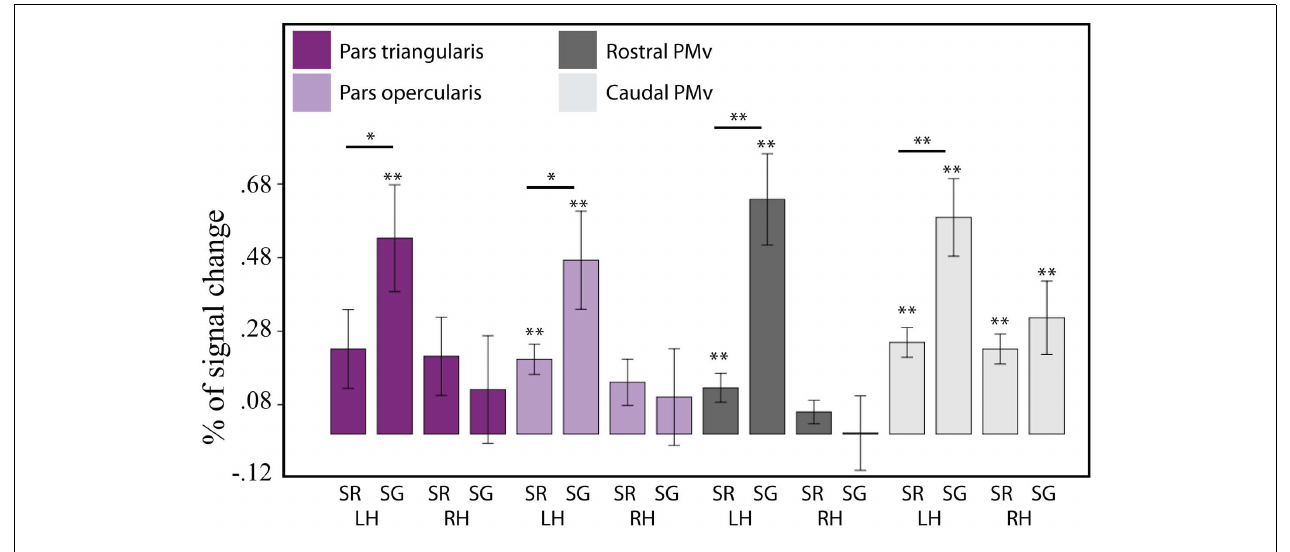
rostral PMv, and caudal PMv. Asterisks indicate significance level: double asterisk indicate that the statistics survive an FDR correction ( q = 0.05); single asterisk indicate uncorrected significance.The error bars represent the SE of the